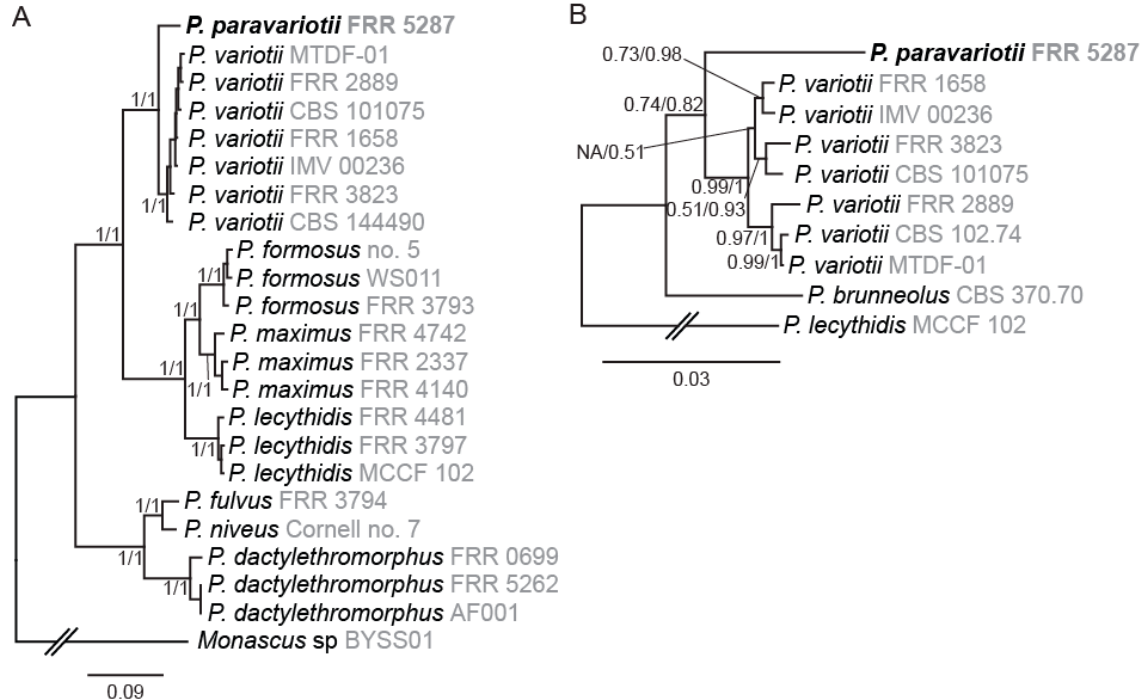
Figure 1. Phylogenetic analysis supports the separation of Paecilomyces strain FRR 5287 into a new species. ( A ) Nine-gene tree showing relationships among genome sequenced Paecilomyces strains. ( B ) Four-gene tree showing relationships among the P. variotii / paravariotii / brunneolus clade. Trees shown were generated in MrBayes. Branch supports indicate bootstraps from maximum likelihood analysis in MEGA-X (first number) and Bayesian probabilities from MrBayes (second number).